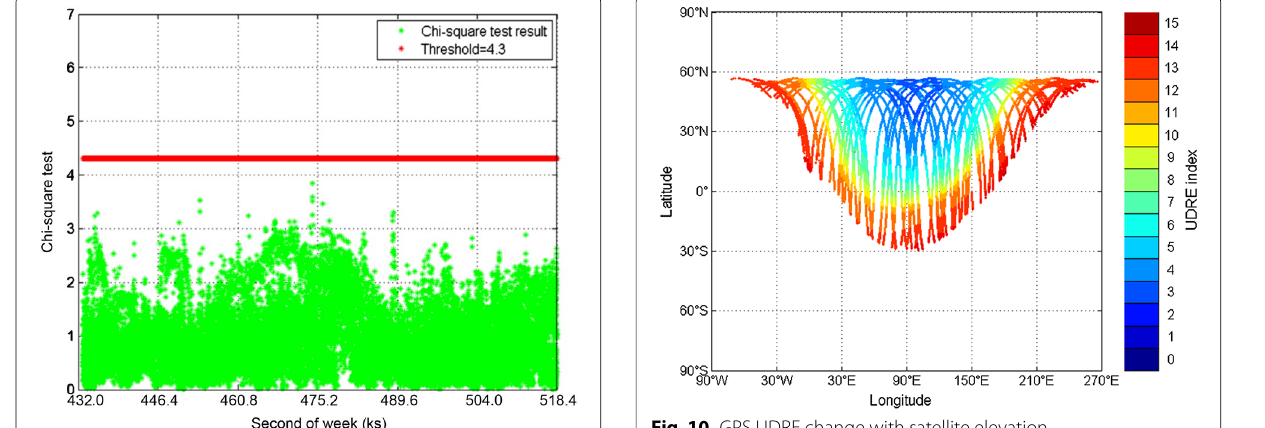
Fig. 10 GPS UDRE change with satellite